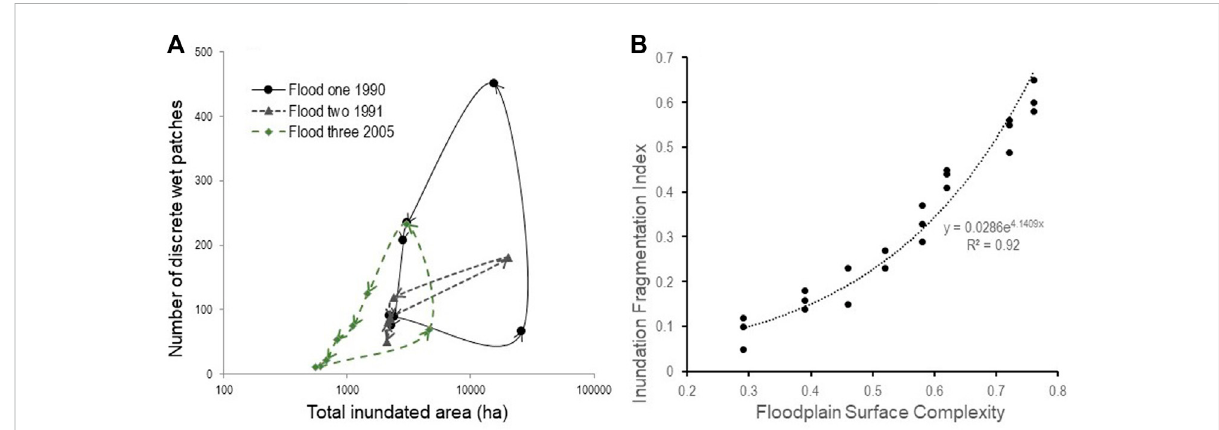
FIGURE 3 Inundation patterns for the Yanga Floodplain. (A) Relationship between total inundated fl oodplain area (hectares) and number of wet patches for thethree fl ood events.Arrowsindicate theconsecutive imagesbyimagecaptured date (modi fi edfrom Shilpakar, 2013). (B) Fragmentation ofthe inundated fl oodplain and fl oodplain surface complexity for the Yanga fl oodplain.